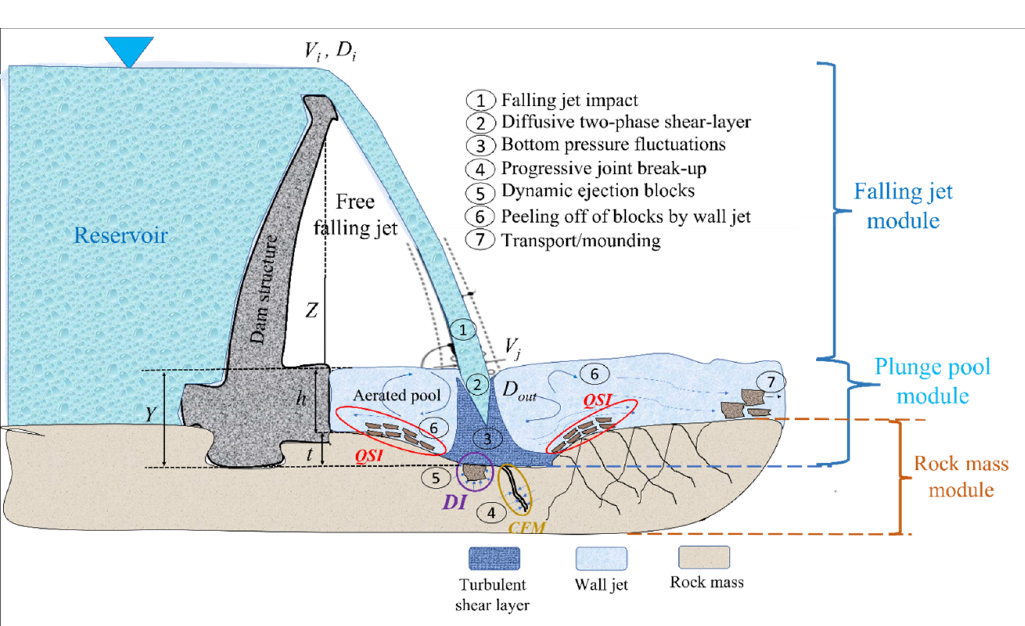
Figure 8. Main physical processes used for computation of rock scour ( CSM) [59,60].